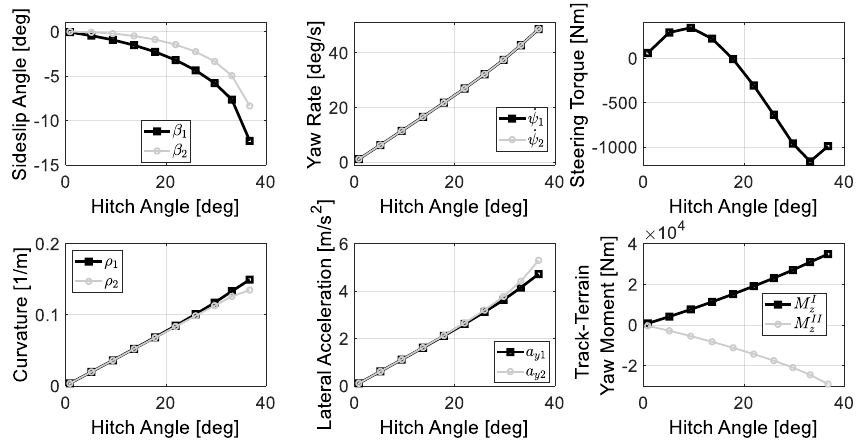
Figure 7. Sideslip angles, yaw rates, steering torque, curvatures, lateral accelerations, and track – terrain yaw moment characteristics from the non-linear model at a constant speed 𝑢 1 = 20 km/h.